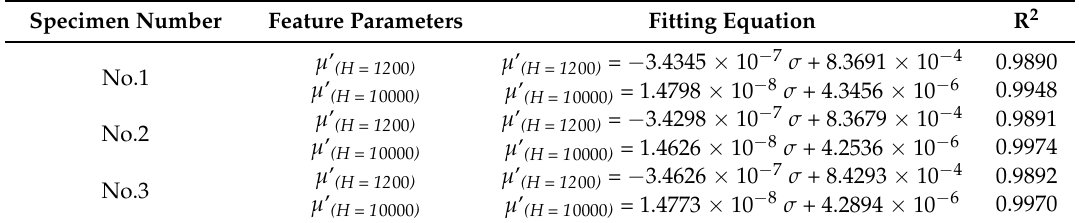
Table 3. The fitting function and goodness R-square of fitted curves µ ’ (H = 12 00 ) ( σ ) and µ ’ (H = 1 0000 ) ( σ ) for different Φ 5 steel